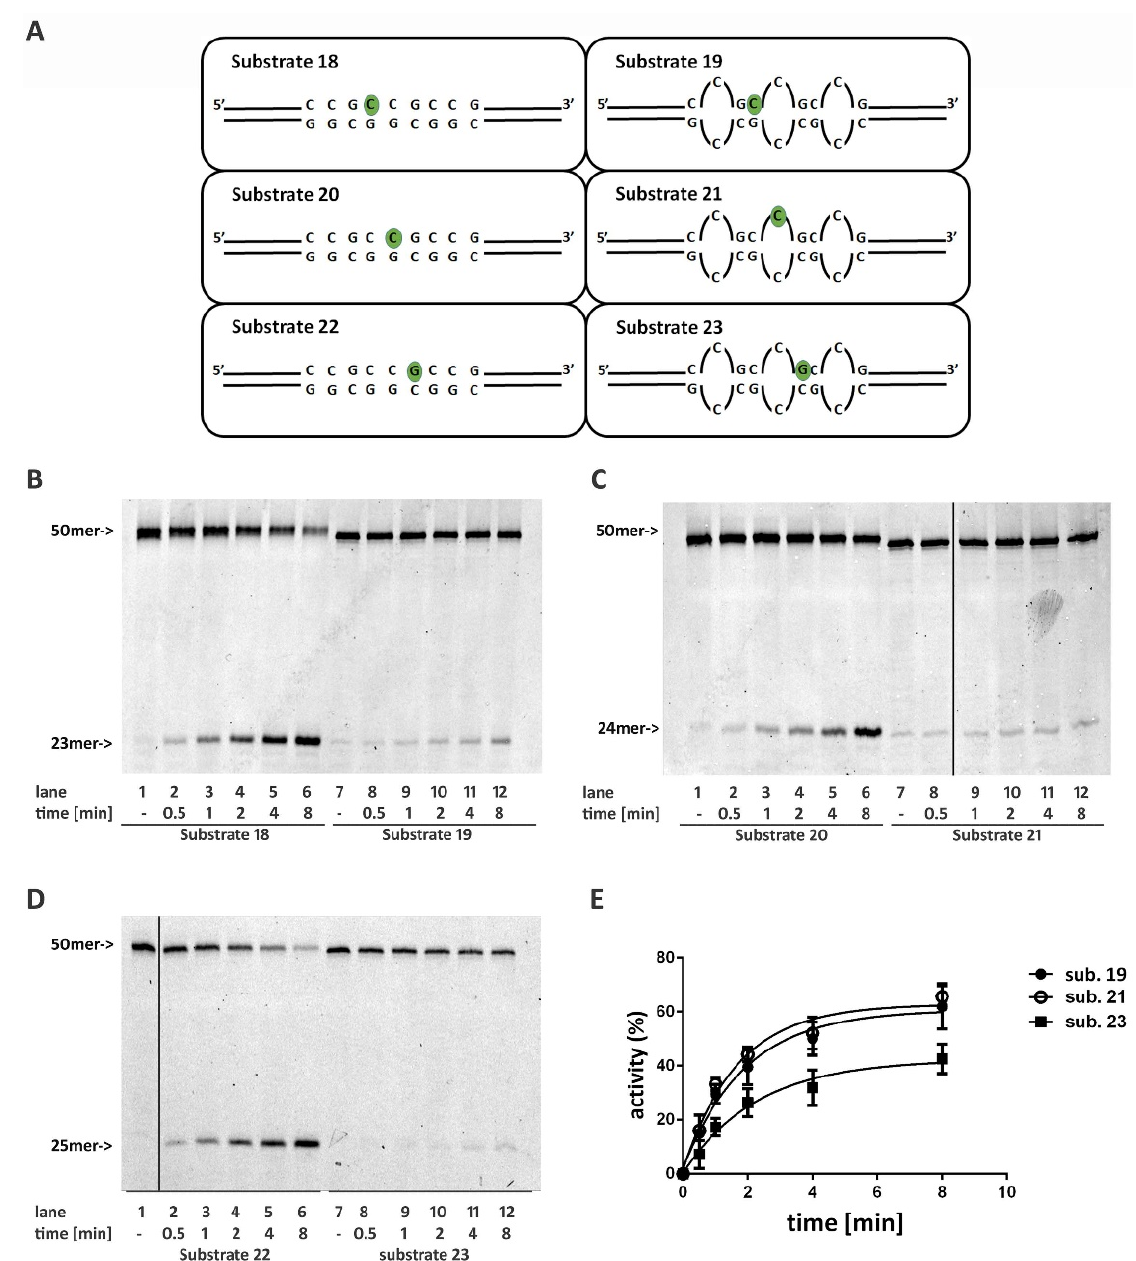
Figure 5. Ribonucleotides embedded in structures mimicking the stem part of CCG hairpins are poor substrates of RNase H2. ( A ) Schematic representation of substrates mimicking the stem of CCG hairpin structures. Time course reactions were performed using 20 nM nucleic acid substrates and 0.4 nM RNase H2. Enzyme activity was compared between ( B ) Substrates 18 and 19 ; ( C ) Substrates 20 and 21 ; ( D ) Substrates 22 and 23. ( E ) Quantification of three independent RNase H2 reactions using Substrates 19 , 21 and 23 . Unprocessed substrates and reaction products are indicated at the left of each panel (50mer and 25mer respectively). Black vertical lines in ( C , D ) represents cropped areas in the raw